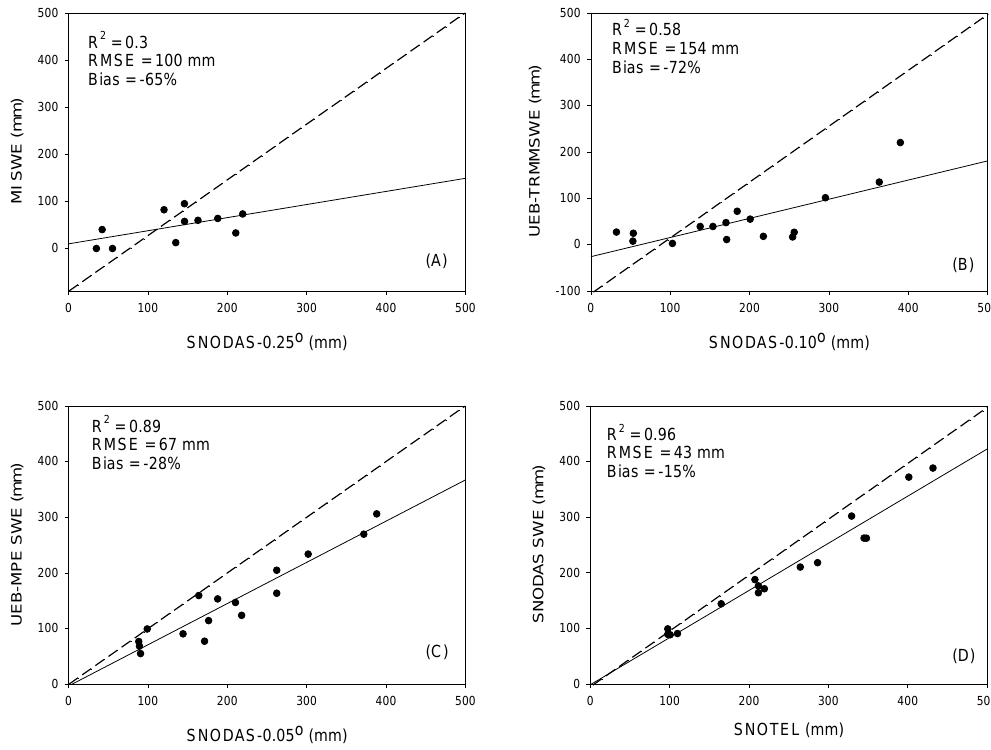
Fig. 10. Averaged SWE (at the 39 SNOTEL sites) from the SNODAS and the (A) SWE estimated from the microwave imagers for December– May between January 2006 and April 2007; (B) SWE from the DisUEB with TRMM precipitation, and (C) DisUEB with MPE for Jan- uary 2006–April 2008. (D) Average SWE of the SNODAS and SNOTEL data sets for the period January 2006–April 2008.